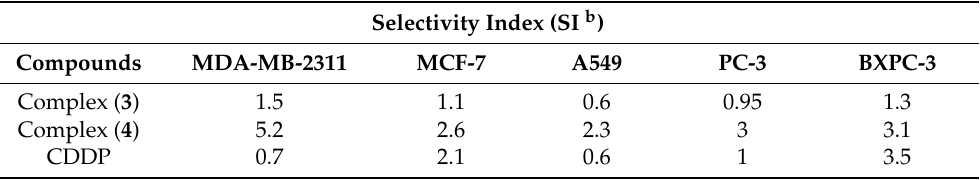
Table 2. Selectivity index of complex(II) and cisplatin for cancer cells. SI = IC 50 for the noncancer line (PBMC)/IC 50 for the cancer cell line.